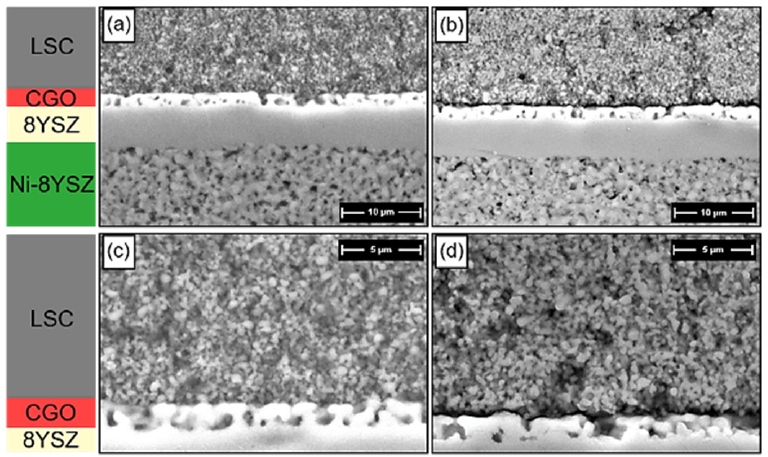
Figure 8. SEM images of the cross-section of the cells ( a , c ) before and ( b , d ) after the long-term test at 800 ◦ C with 50% H 2 + 50% H 2 O. SEM images focused on oxygen electrode side ( c , d